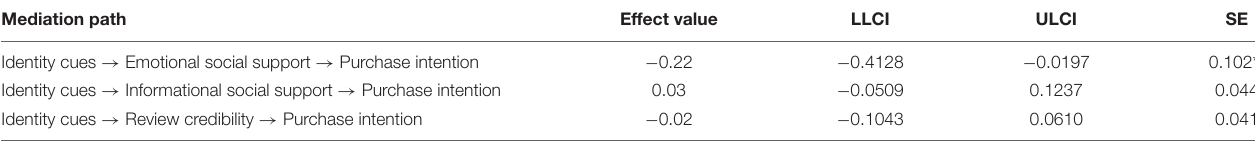
TABLE 5 | Mediating effects between identity cues and purchase intention under partial negative reviews